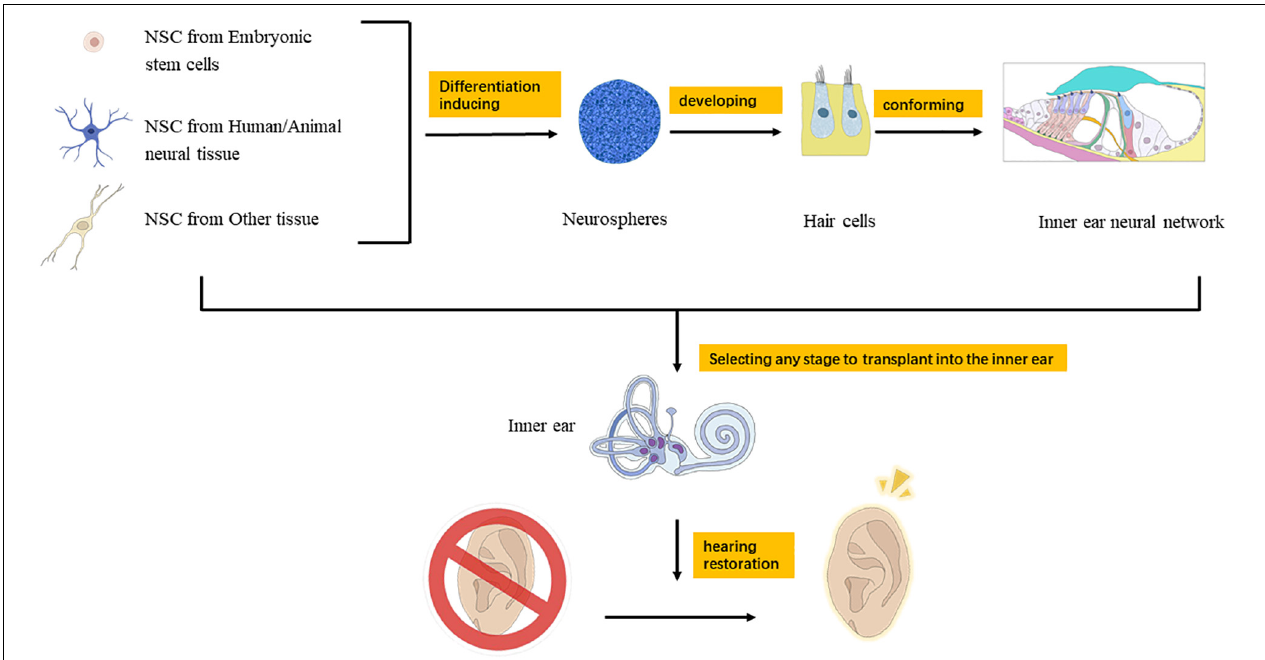
FIGURE 1 | Mechanism of neural stem cell transplantation for the treatment of hearing